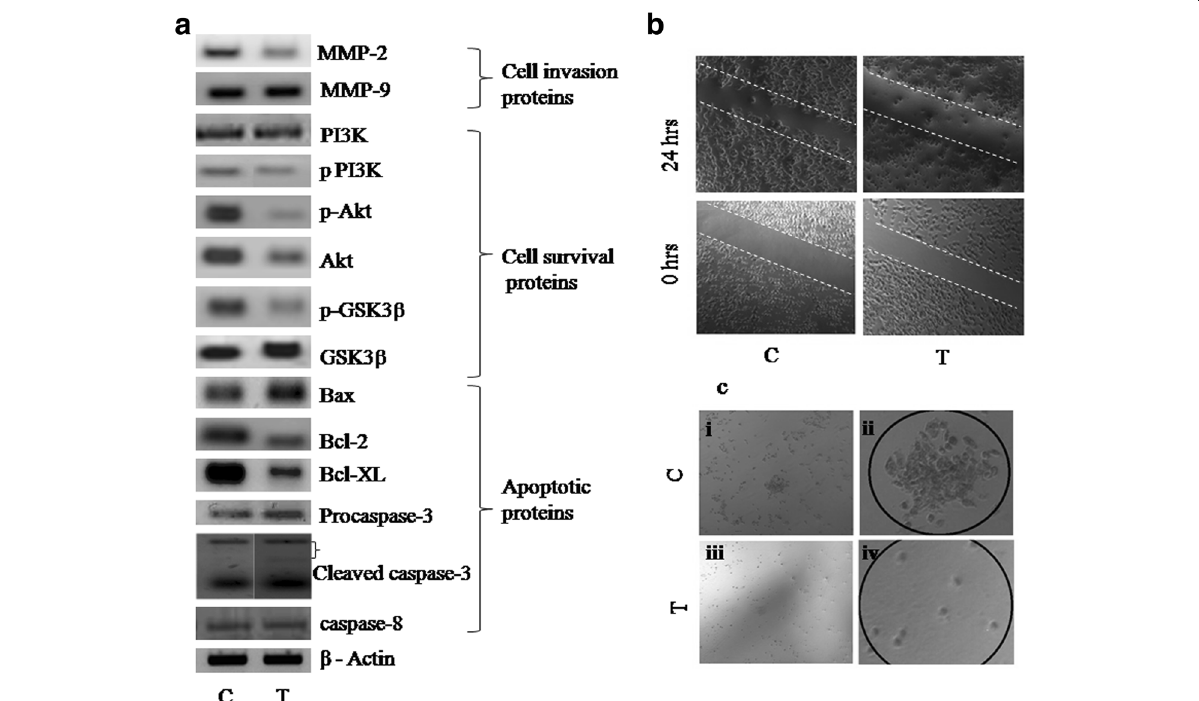
Fig. 4 Analysis of protein expression. a Western blot analysis of procaspase-3, cleaved caspase3, caspase-8, Bax, Bcl-2 and Bcl-XL, p-Akt, Akt, p-GSK3 β and GSK3 β , PI3K, p-PI3K, MMP2 and MMP9. β actin was used to check equal loading. b The scratch assay shows the inhibition of cell invasion into the wound region after 24 h of GAE treatment (1 mg/ml). c The clonogenic assay result shows the inability of single cells to proliferate as a colony after GAE treatment (1 mg/ml). (i) Colony formed in control cells after 7 days, (ii) magnified colony of control cells, (iii) Treated cells after 7 days, (iv) treated cells magnified. C-control,